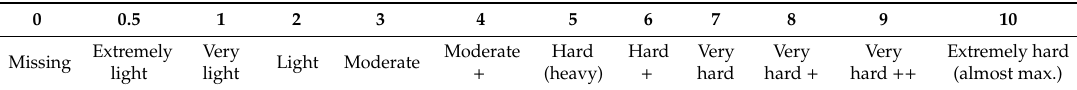
Table 2. Subjective assessment of perceived exertion perception by Borg